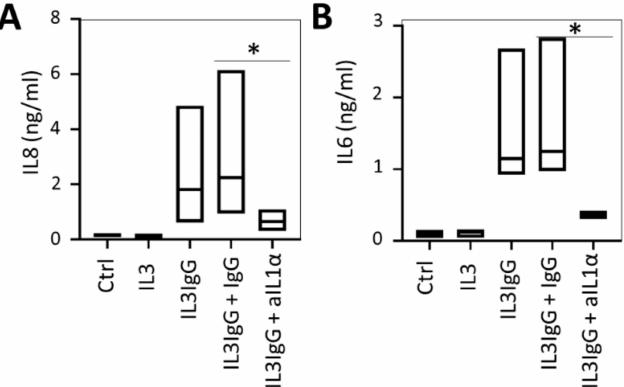
Figure 3. Release of IL6 and IL8 by human bronchial fibroblasts stimulated with eosinophil soluble mediators is dependent on activation by IL1 α . HBF were stimulated with eosinophil supernatants (IL3 or IL3IgG) or basal medium (Ctrl). IL3IgG supernatants were incubated for 1 h with either IgG control antibody (1 µ g/mL) or IL1 α neutralizing antibody (aIL1 α , 1 µ g/mL) prior to stimulation, as indicated. Twenty-four hours later, HBF supernatants were collected, and IL8 ( A ) and IL6 ( B ) levels were analyzed via ELISA ( n = 4 for all conditions). Paired Student’s t -test was used to test for statistically significant differences (* p <